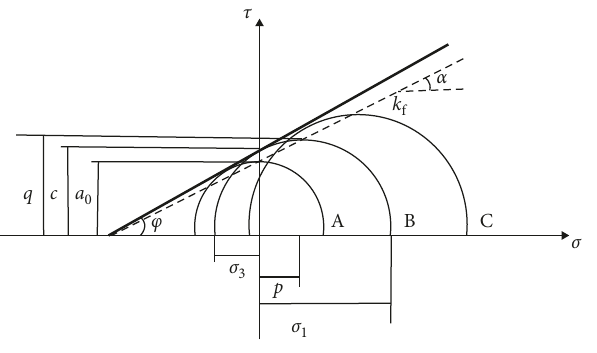
Figure 3: Mohr stress circle under normal